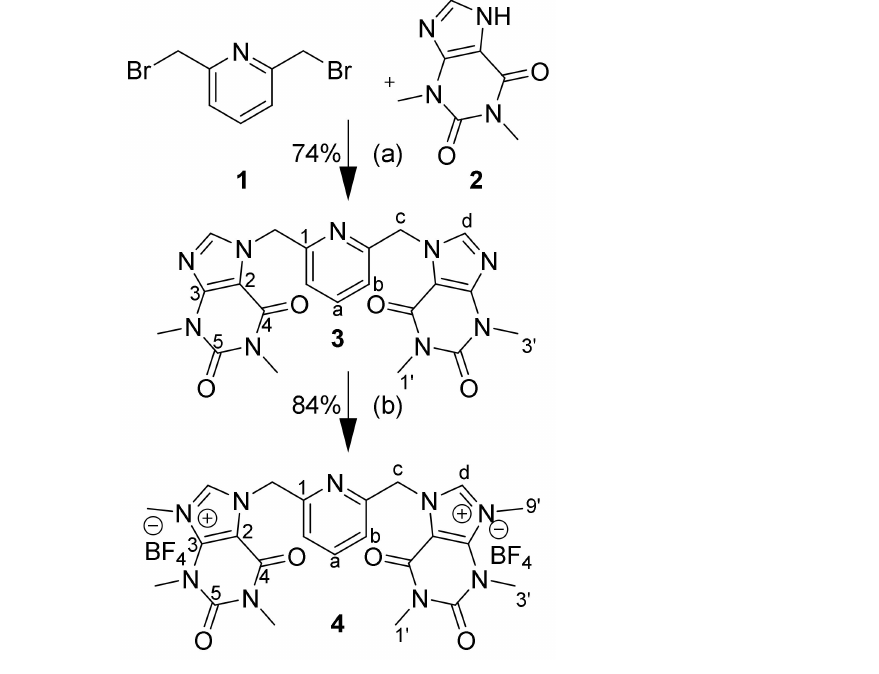
Scheme 2. Schematic representation of the synthesis of precursor 4 , including the numbering of